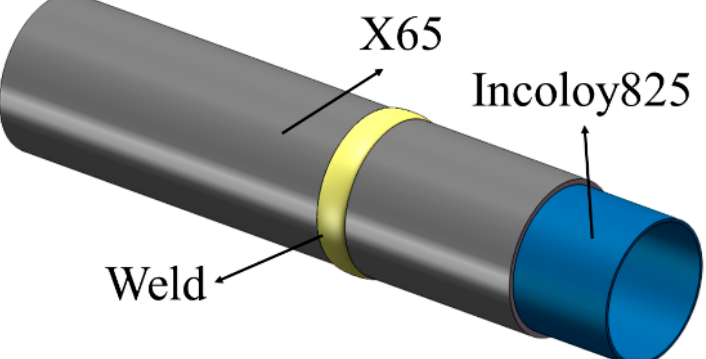
Figure 1. Schematic diagram of X65/Incoloy825 bimetallic composite pipe. Table 1. Chemical compositions of Incoloy825, X65 and weld (wt.%).